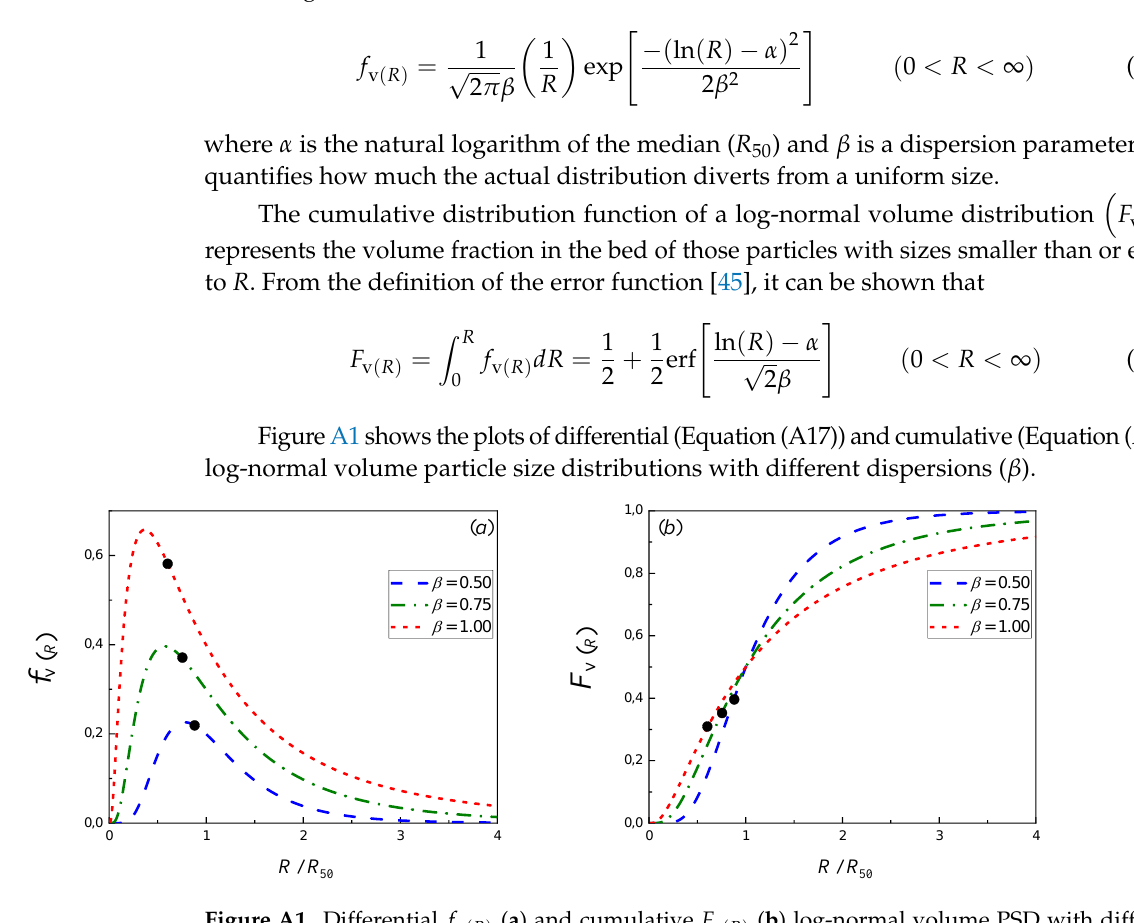
Figure A1. Differential f v ( R ) ( a ) and cumulative F v ( R ) ( b ) log-normal volume PSD with different dispersions ( β ). The thick dots indicate the location of R m / R 50 (Equation (A21)).